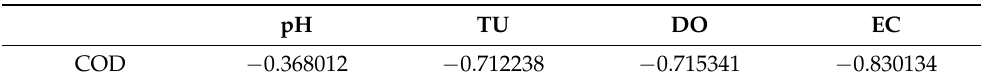
Table 2. Correlation coefficients of item 2.